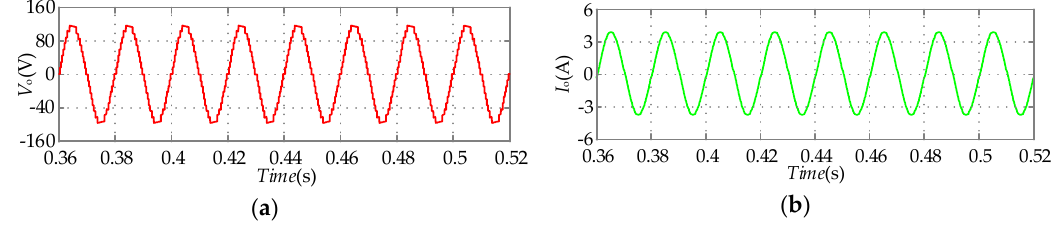
Figure 14. Waveforms of the seventeen-level inverter. ( a ) Voltage; ( b ) current.